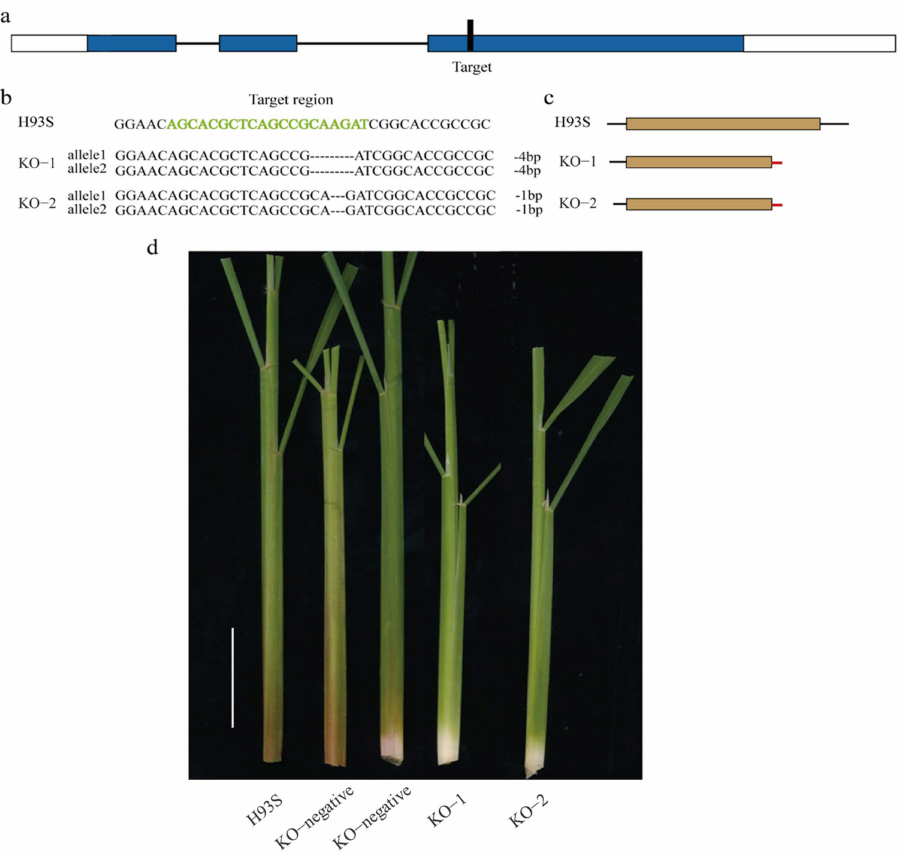
Figure 4. Knocking–out (KO) of OsC1 PLSr in H93S by CRISPR/Cas9 genomic editing system. ( a ), The schematic representation of the target site position. ( b ), Sequencing analysis of target regions of mutant lines. ( c ), Amino acid changes in mutant lines. ( d ), The whole plant of H93S and the KO plants. The KO–negative failed to Knocking–out the OsC1 PLSr gene in H93S by CRISPR/Cas9 genomic editing system. The scale bar is 5 cm.